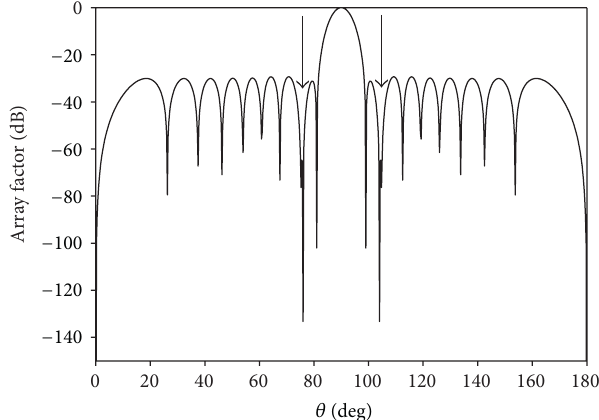
Figure 4: Radiation pattern obtained by amplitude-only control with one imposed null at 104 ∘ .